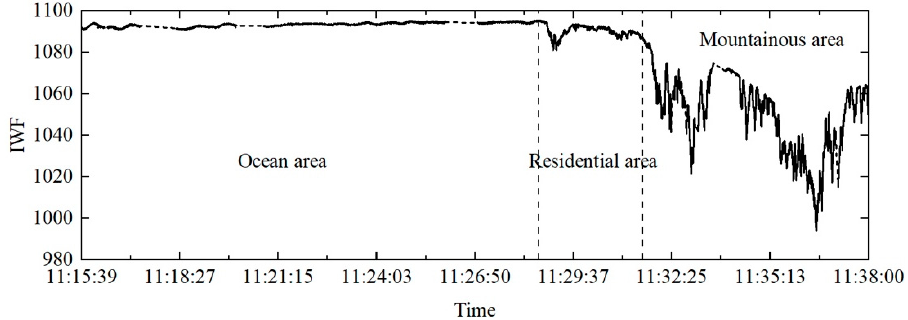
Figure 4. The integrated weighting function (IWF) results on 14 March 2019.